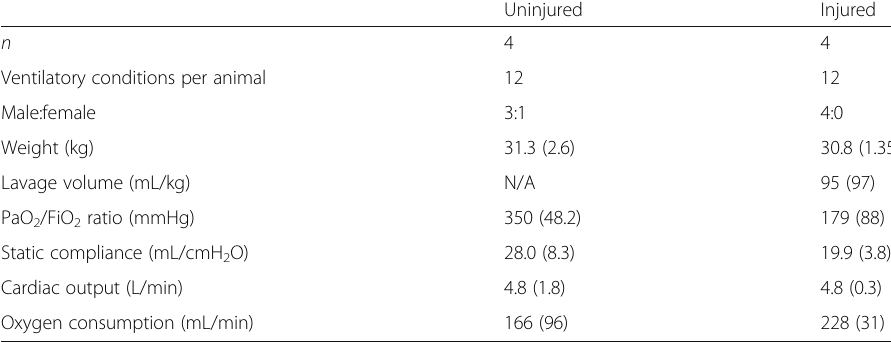
Uninjured Injured